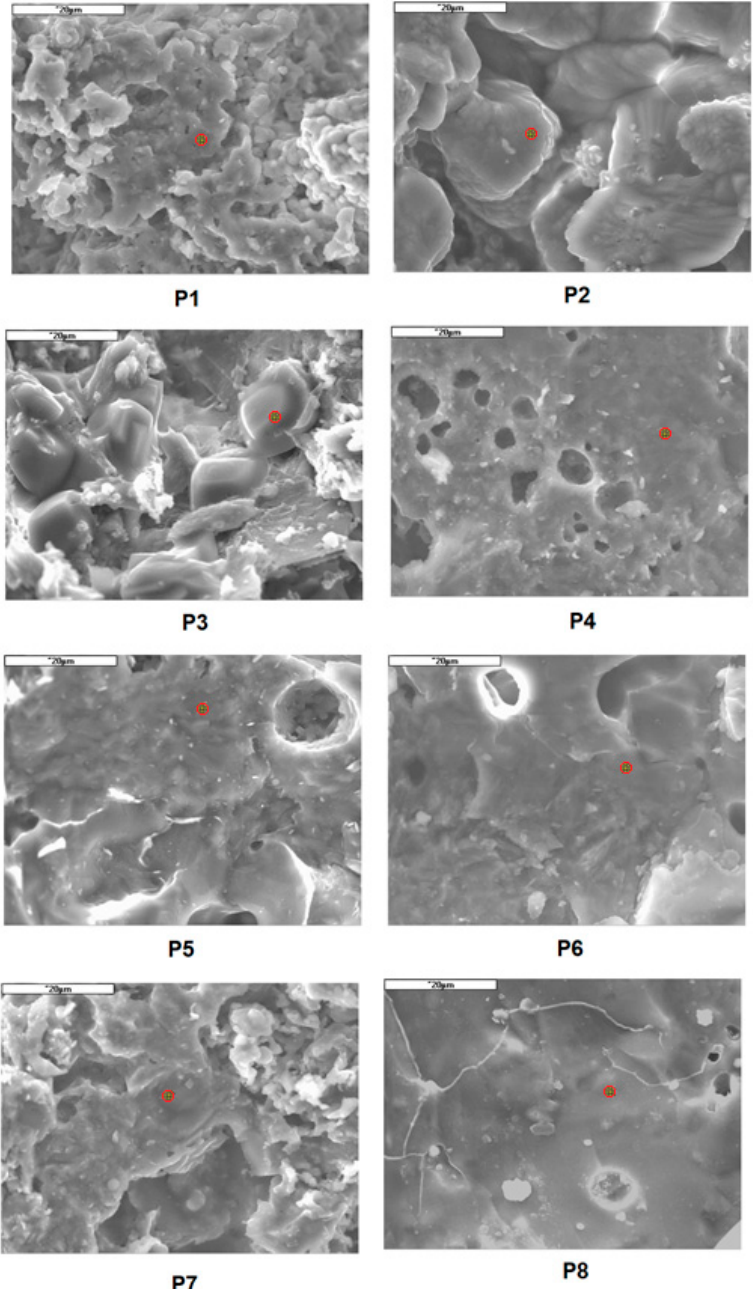
Figure 7. Microphotographs of samples containing a successively increased amount of gres porcellanato mass.